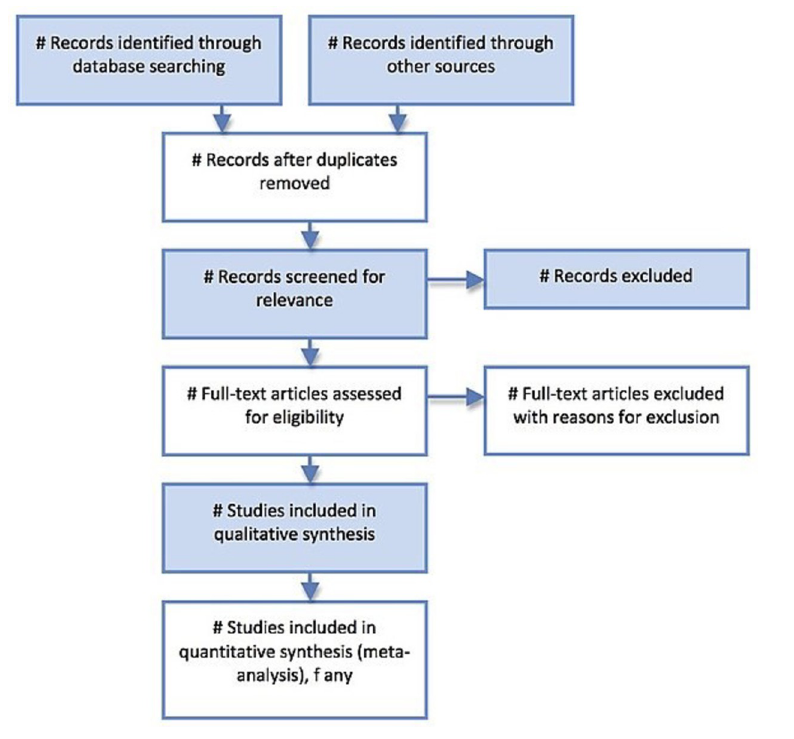
Fig 1. Sample PRISMA flow chart.